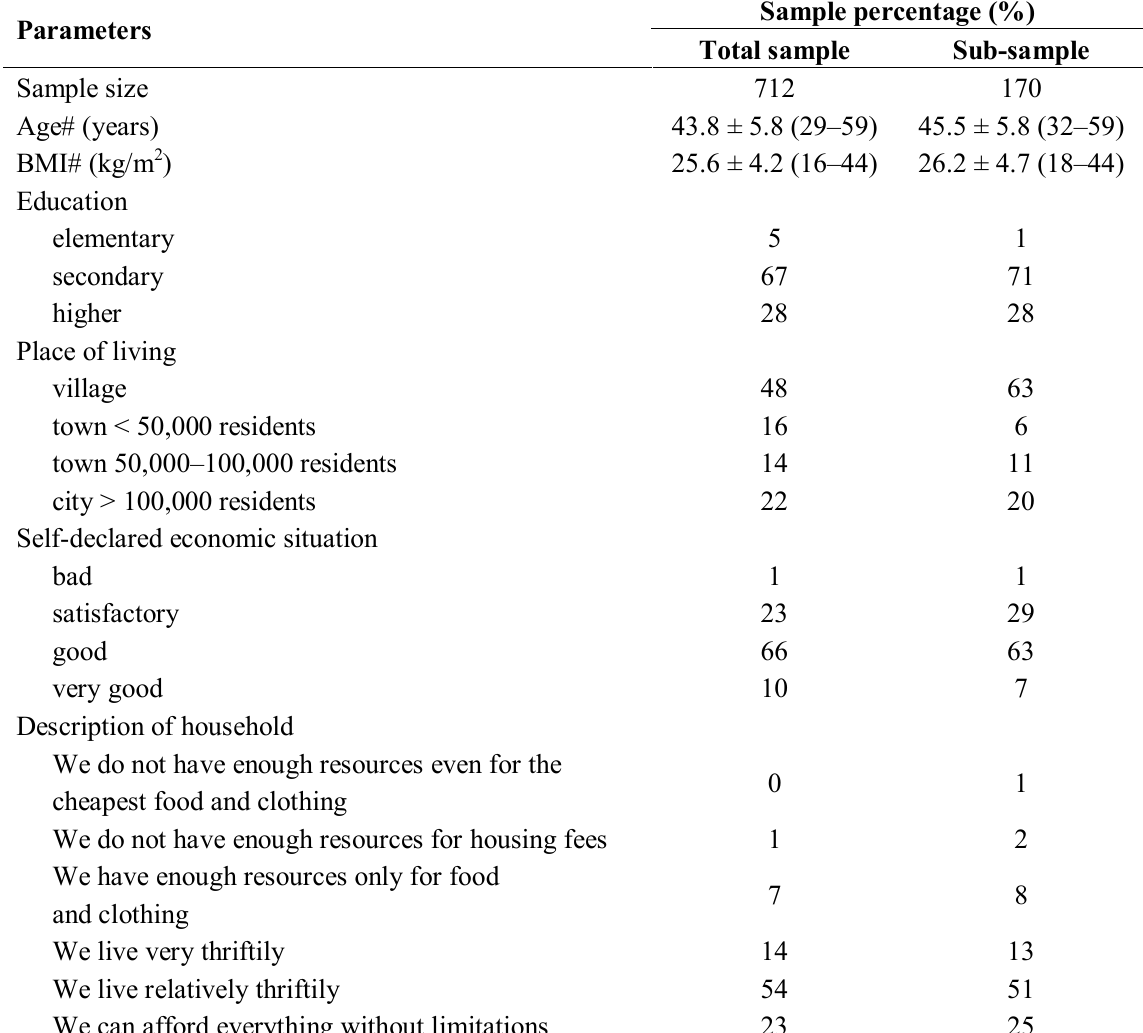
Table 1. Description of the total sample and sub-sample of women tested with bone